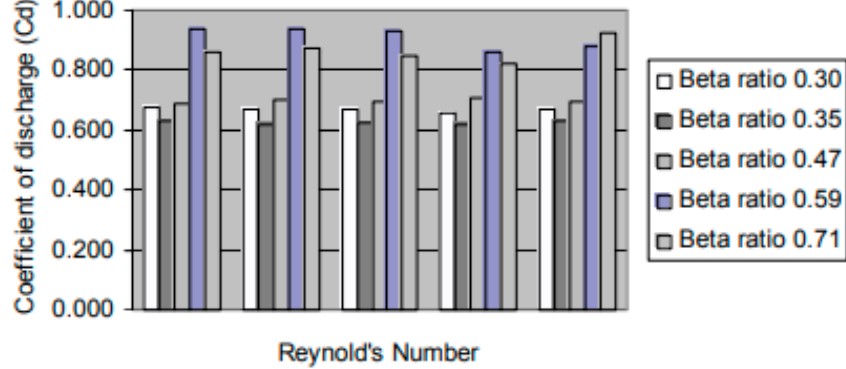
Figure 2. Bar diagram of coefficient of discharge (C d ) for different beta ratios